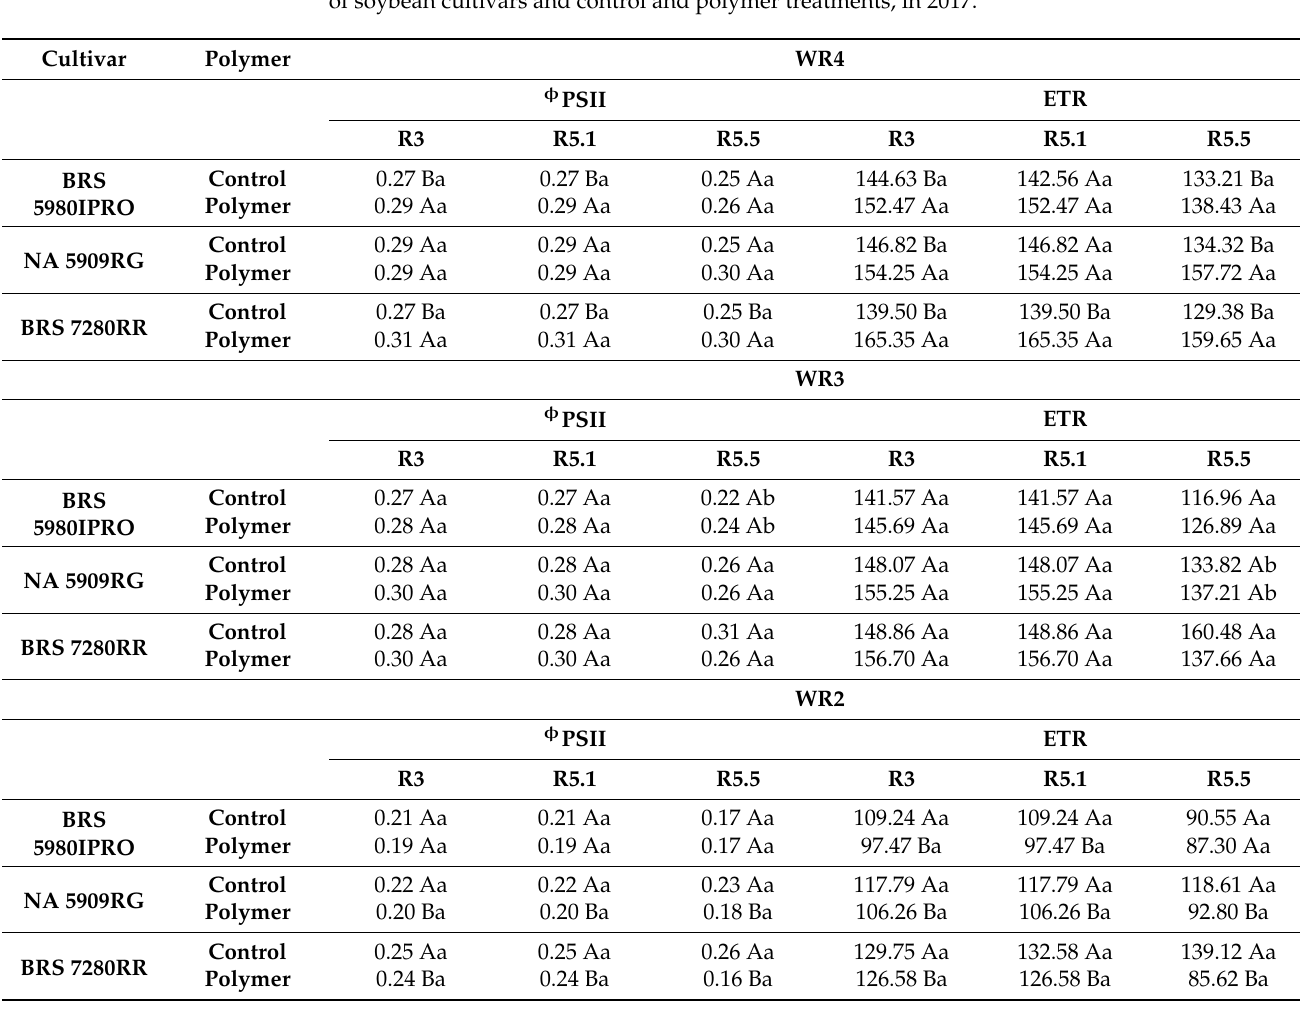
Table 4. Photosystem II yield ( φ PSII) and electron transport rate (ETR) in three phenological stages of soybean cultivars and control and polymer treatments, in